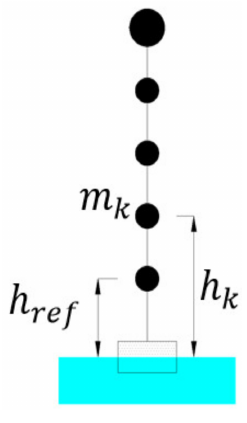
Figure 3. Lumped mass model of floating wind